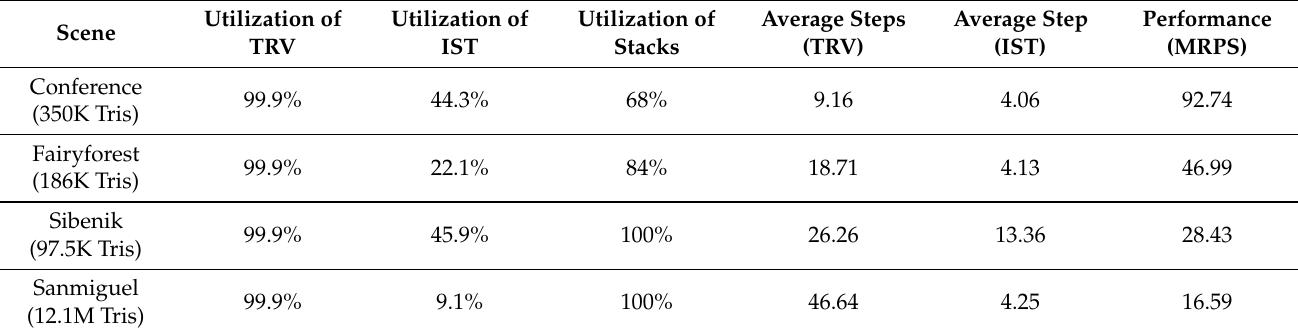
Table 6. Performance comparison of the proposed ray-tracing